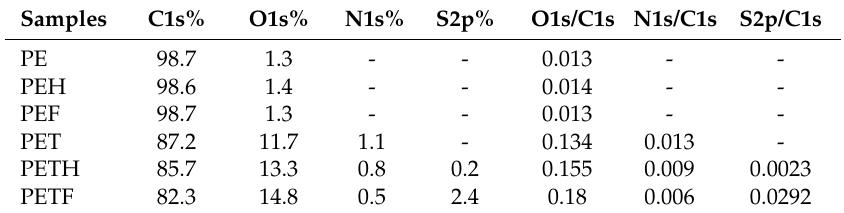
Table 2. Elemental compositions and ratios of the tested surfaces obtained by X-Ray photoelectron spectroscopy